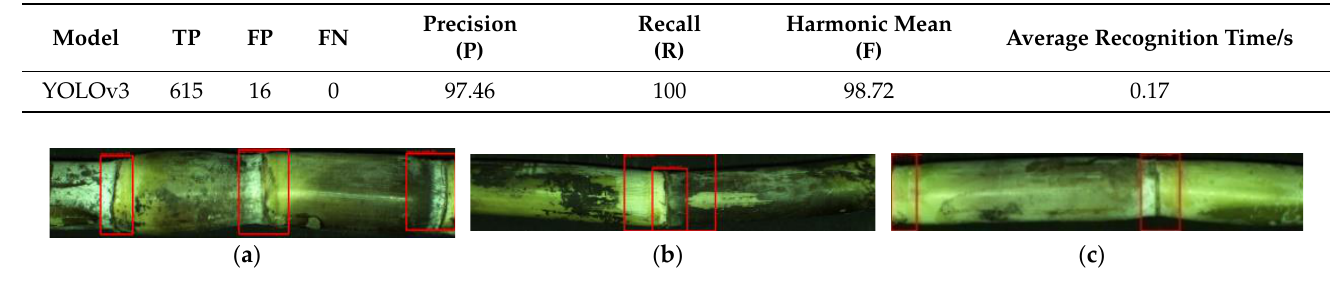
Table 1. Statistics of the detection results.